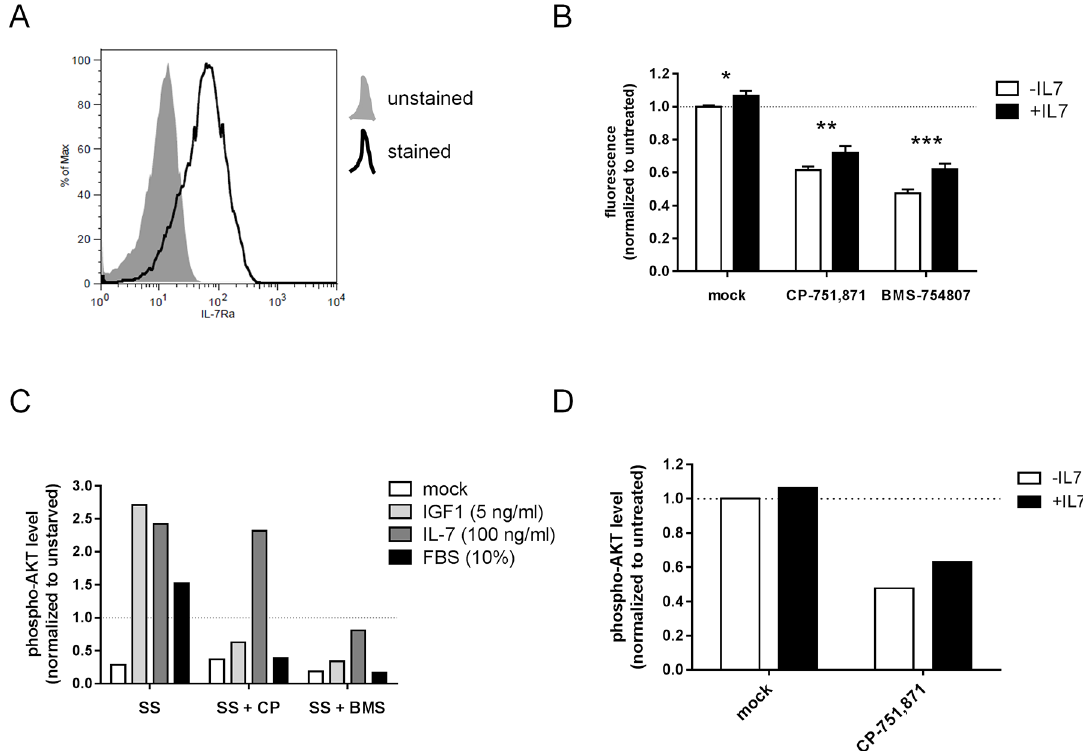
Fig 7. Signaling through IL7R does not rescue T-ALL cells from IGF1R inhibition nor maintain prolonged activation of AKT. ( A ) Flow cytometric analysis for surface IL7R expression level in HPB-ALL cells cultured under routine conditions. ( B ) Cell growth as measured by resazurin reduction assay. HPB-ALL cells were cultured in vitro for 3 days with IGF1R blocking antibody (1 μ g/ml CP-751,871) or IGF1R/InsR tyrosine kinase inhibitor (0.5 μ M BMS-754807) with or without supplemental recombinant IL-7 (100 ng/ml, added once at the beginning of the culture period). Mean resorufin fluorescence values +/- SD after normalization to untreated control are plotted for assays performed in triplicate. * , p < 0 . 05; ** , p < 0 . 01; *** , p < 0 . 001 (2-way ANOVA with Sidak ’ s multiple comparisons test ). ( C,D ) Flow cytometric analysis for intracellular phospho-AKT. ( C ) HPB-ALL cells were serum starved with or without IGF1R inhibition for 24 hours, and then pulsed with IL-7, IGF-1 or FBS for 10 minutes. Mean fluorescence intensity after normalization to unstarved, untreated control is plotted for a representative example of assays performed in duplicate. SS , serum starved; CP , CP-751 , 871 (1 μ g/ml); BMS , BMS-754807 (0 . 5 μ M) . ( D ) HPB-ALL cells were cultured in vitro for 3 days with IGF1R blocking antibody (1 μ g/ml CP-751,871) with or without supplemental recombinant IL-7 (100 ng/ml). Mean fluorescence intensity after normalization to untreated control is plotted for a representative example of assays performed in